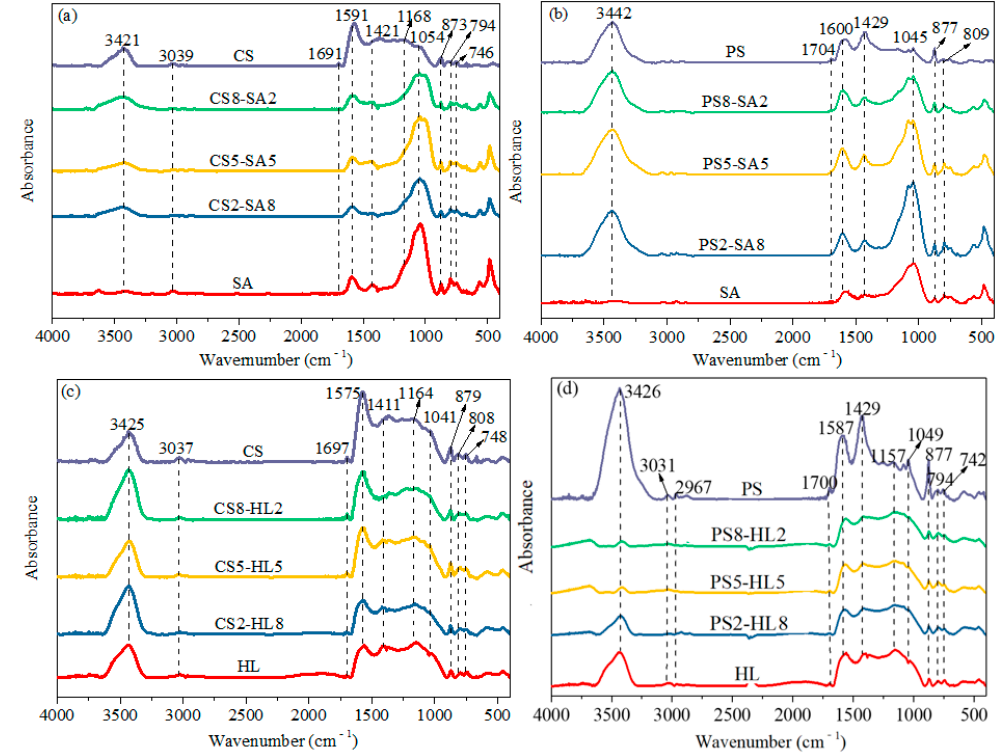
Figure 5. FTIR spectra of char samples with different biomass mass ratios: ( a ) SA char with different CS mass ratios, ( b ) SA char with different PS mass ratios, ( c ) HL char with different CS mass ratios, ( d ) HL char with different PS mass ratios.